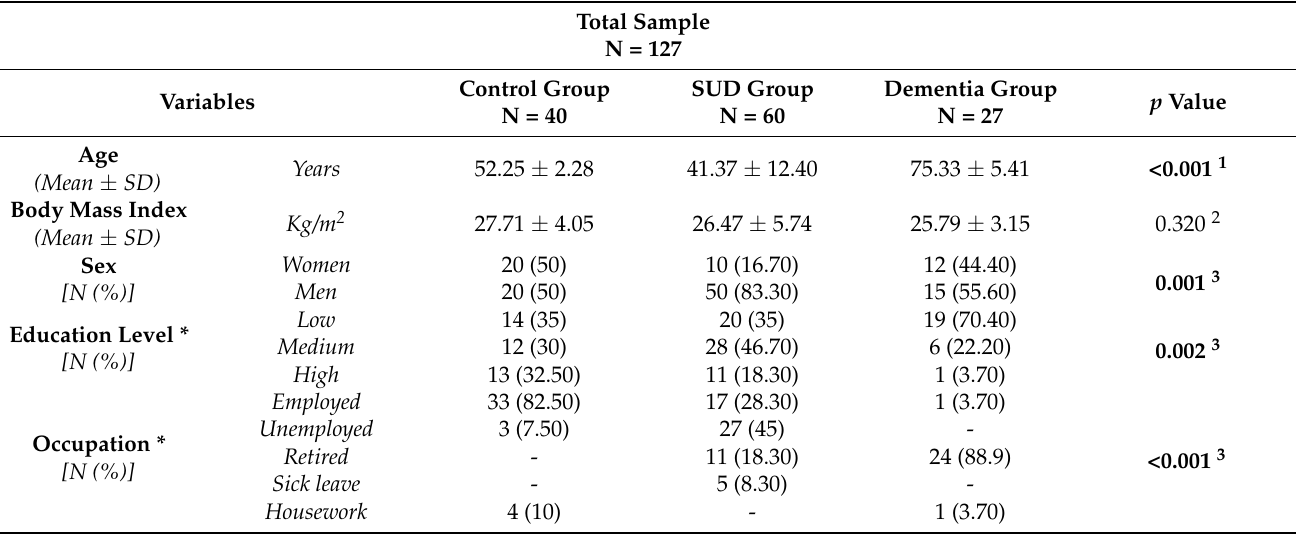
Table 1. Socio-demographic characteristics of the sample.